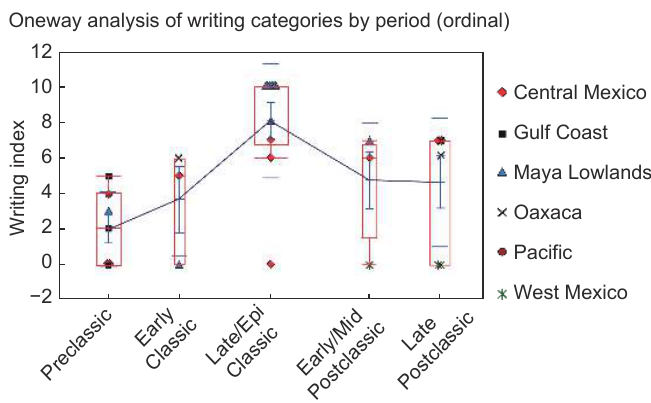
Fig. 4 Uses of Mesoamerican writing over